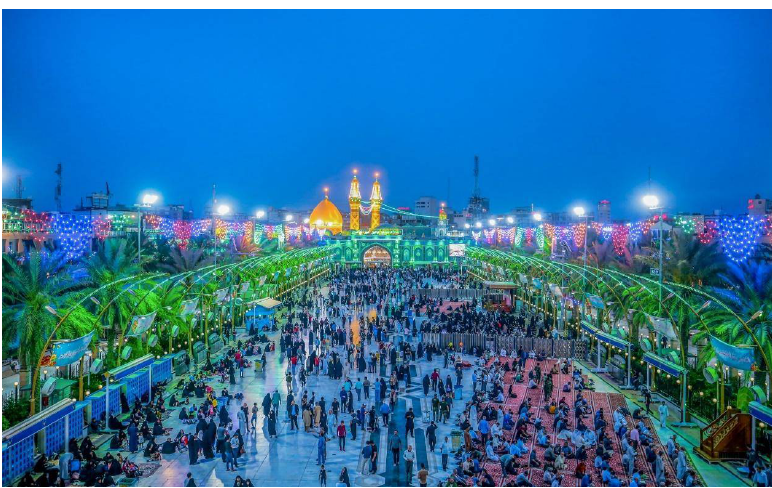
Figure 6. The Modernised Bayn al-Haramayn’ Pedestrian. Source: “Photo Gallery”, ImamHussain.org—(n.d.) https://pic.imamhussain.org/gallery/show/16149 accessed on 1 October 2021.